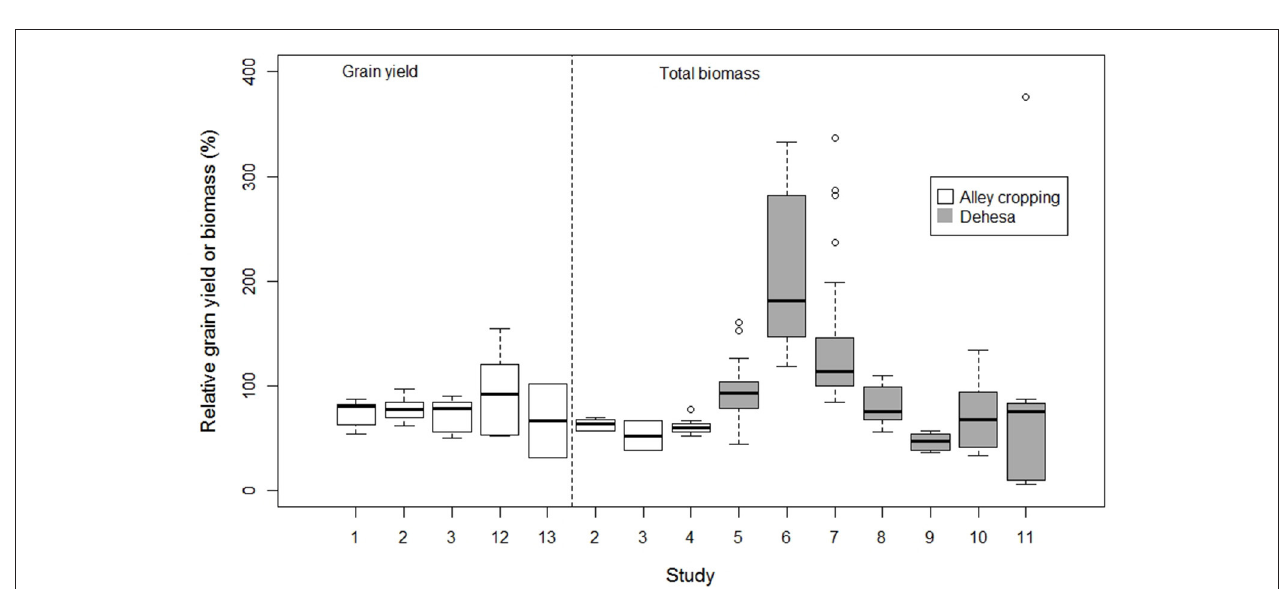
FIGURE 4 | Boxplot of relative crop yield (%) based on grain yield (left part) or based on total biomass (right part) for each study. Studies 2 and 3 reported both relative grain yield and relative biomass, and these are both shown. For further explanation, see legend of Figure 2 .